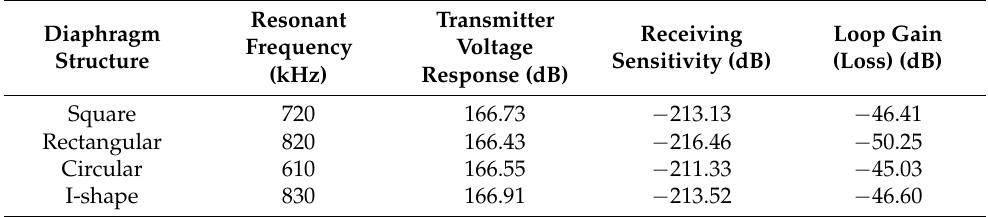
Table 4. The performances of four pMUTs with different diaphragms in the absolute ethanol